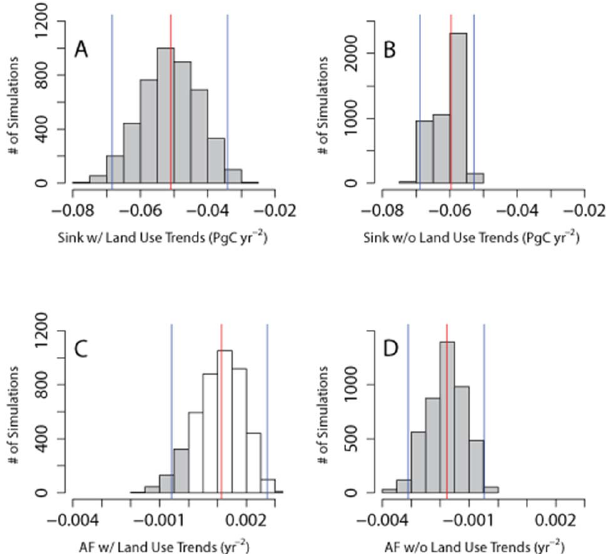
Figure 8. Trends in global carbon uptake. Plotted are the histograms of slopes fitted to 4500 simulations of net global carbon uptake, i.e., global sink (cid:54)N in (a) and (b) and the airborne fraction (AF) in panels c and d . Also plotted are the slopes fitted to 4500 simula- tions without land use emissions included for (cid:54)N (b) and AF (c) . Negative trend slopes (grey filled bars) of (cid:54)N indicate accelerating net global C uptake, whereas positive slopes (open bars) of AF in- dicate a decrease in relative C uptake efficiency. The median slope values are overlaid (red lines) for comparison with the 2 σ trend cal- culations (blue lines).